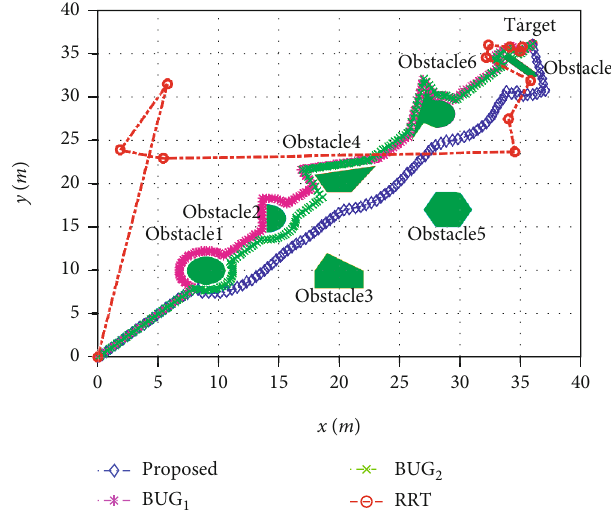
Figure 14: Scenario 2: the result of path planning of the four algorithms with multiple obstacles. Table 2: The simulation parameters in Figures 11 – 14. Table 3: Time consumption of the four algorithms in Figures 11 Figure 11 Figure 12 Figure 13 Figure 14